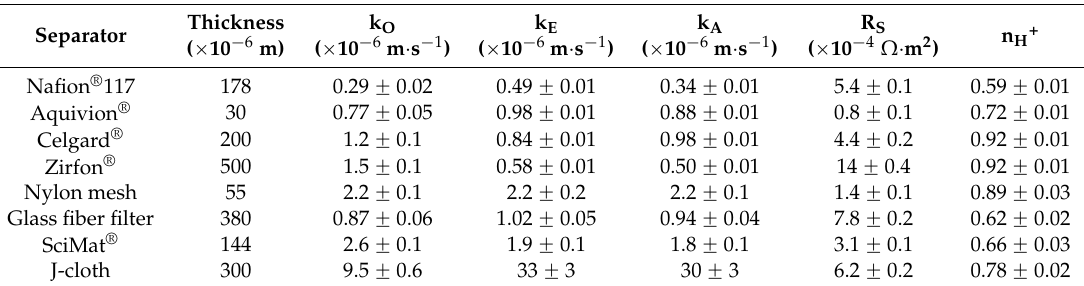
Table 2. Characteristics of the separators measured in the non-inoculated air breathing and aqueous